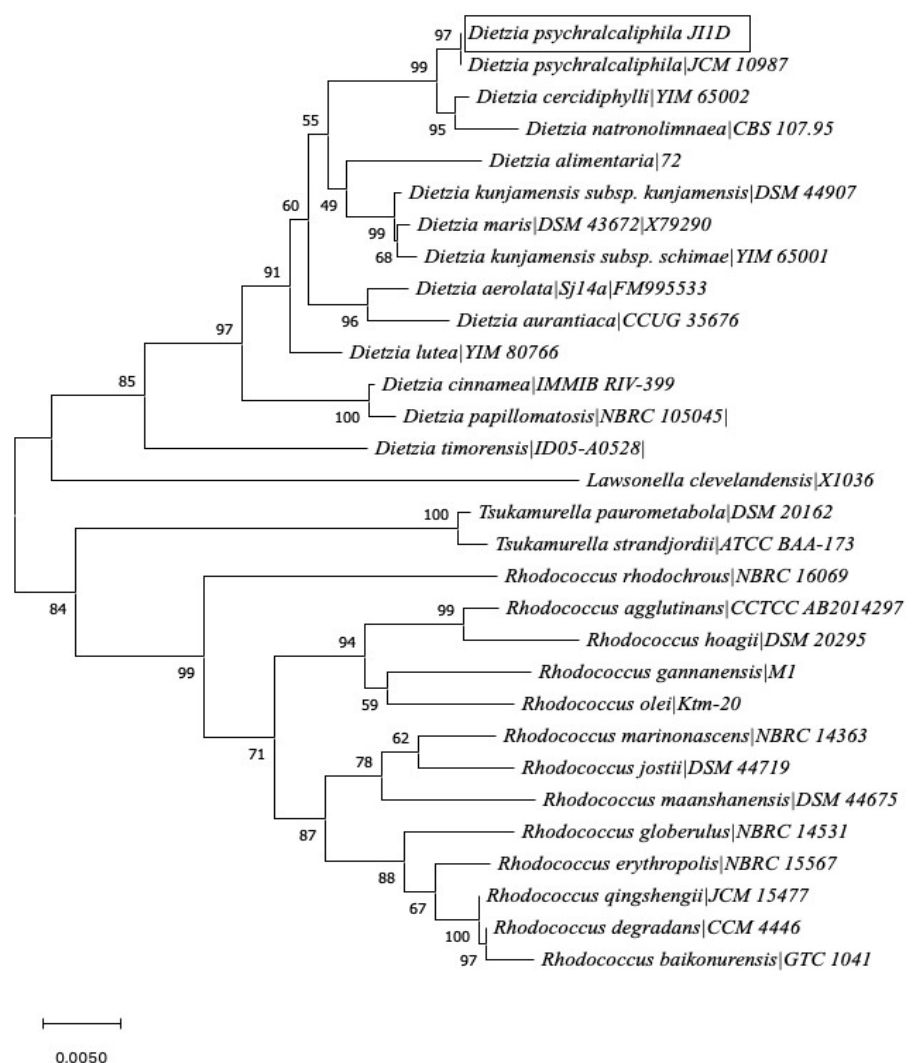
Figure 1. Evolutionary relationship of D. psychralcaliphila JI1D predicted by 16S rRNA sequencing.